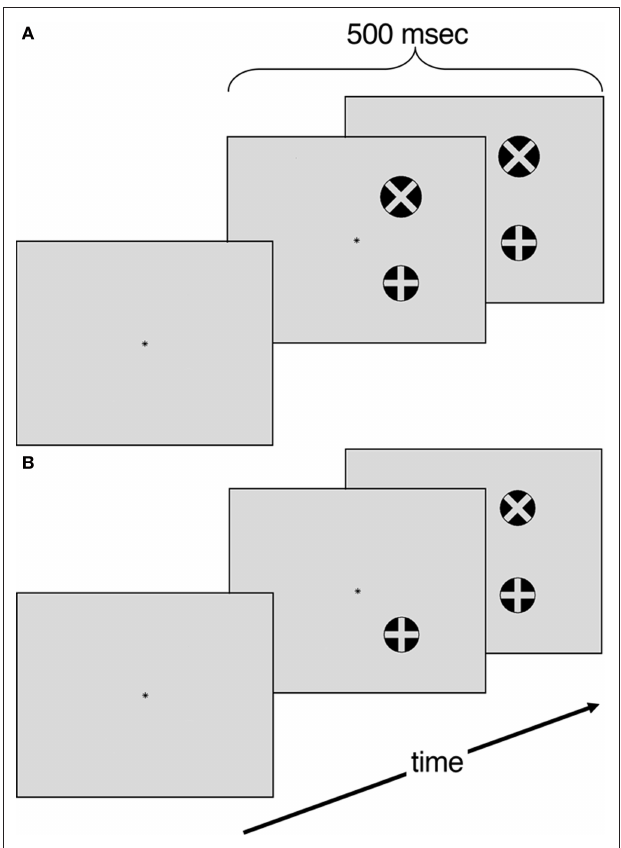
Figure 1 | (A) Size judgment task. Four different areas (104, 108, 110, 113% of standard) (B) Temporal order judgment task. Four temporal offsets (40, 53, 67, 80 ms).